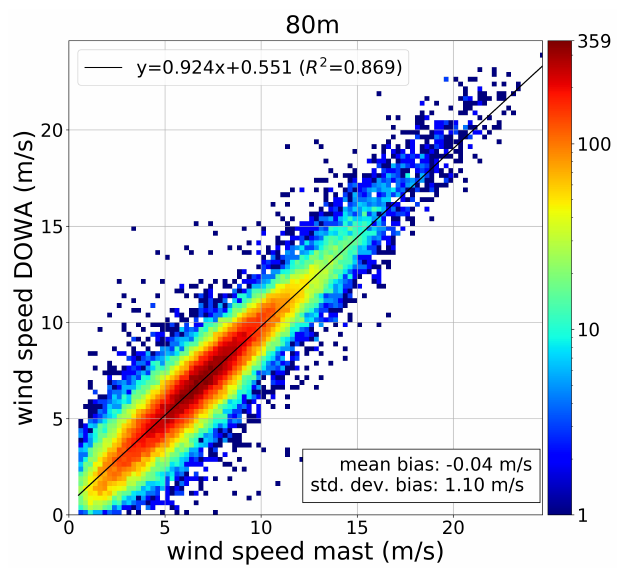
Figure 8. Scatterplot of the DOWA and mast wind speed data at 80 m (visualized as a density plot with logarithmic color scale).